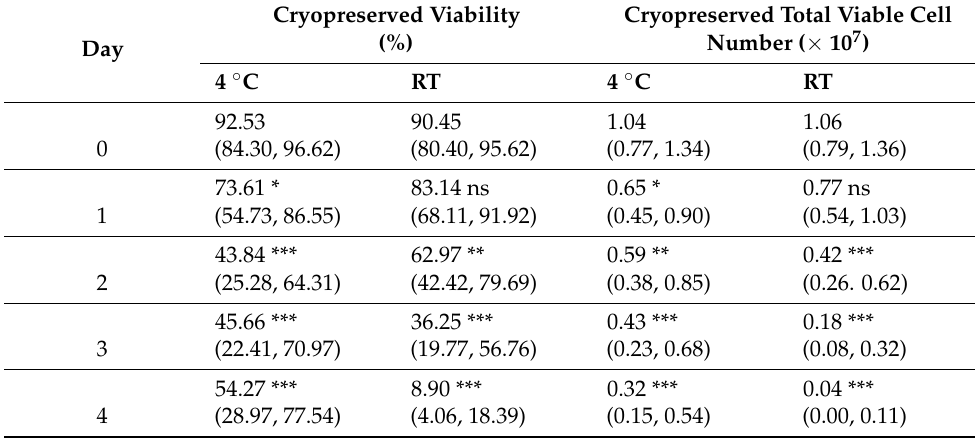
Table 1. The comparison in cryopreserved viability and total viable cell number measured at different days of storage in either 4 ◦ C samples or RT